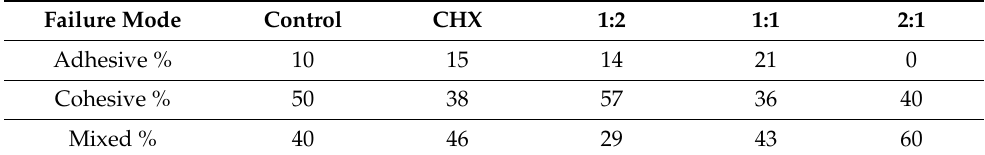
Table 2. Percentages of the different failure modes for each tested group ( n = 10).